Question: Briefly state, in one sentence, what is plotted here.
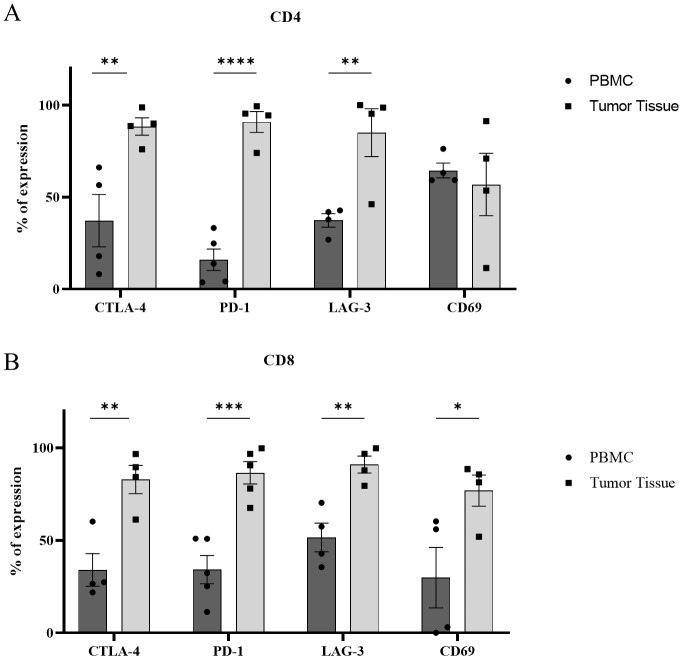
Answer: Checkpoint expression in T-cells isolated from the blood or the tumor tissue of PDAC patients. Checkpoint expression in CD4 + (A) and CD8 + (B) T-cells isolated from the blood or the tumor tissue of PDAC patients was analyzed by flow cytometry. T-cells identified as CD3 + and CD45 + were analyzed for surface expression of CTLA-4, PD-1, LAG-3 and CD69. T-cells isolated from the tumor tissue were compared to T-cells isolated from the blood. Error bars indicate the standard errors of the mean of four independent patients, with **p ≤ 0.01; ***p ≤ 0.005; ****p ≤ 0.0001.